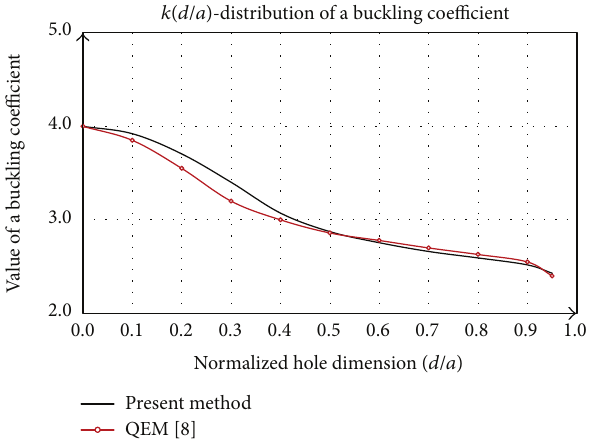
Figure 8: Comparative analysis of buckling coefficient of square plate with a circular